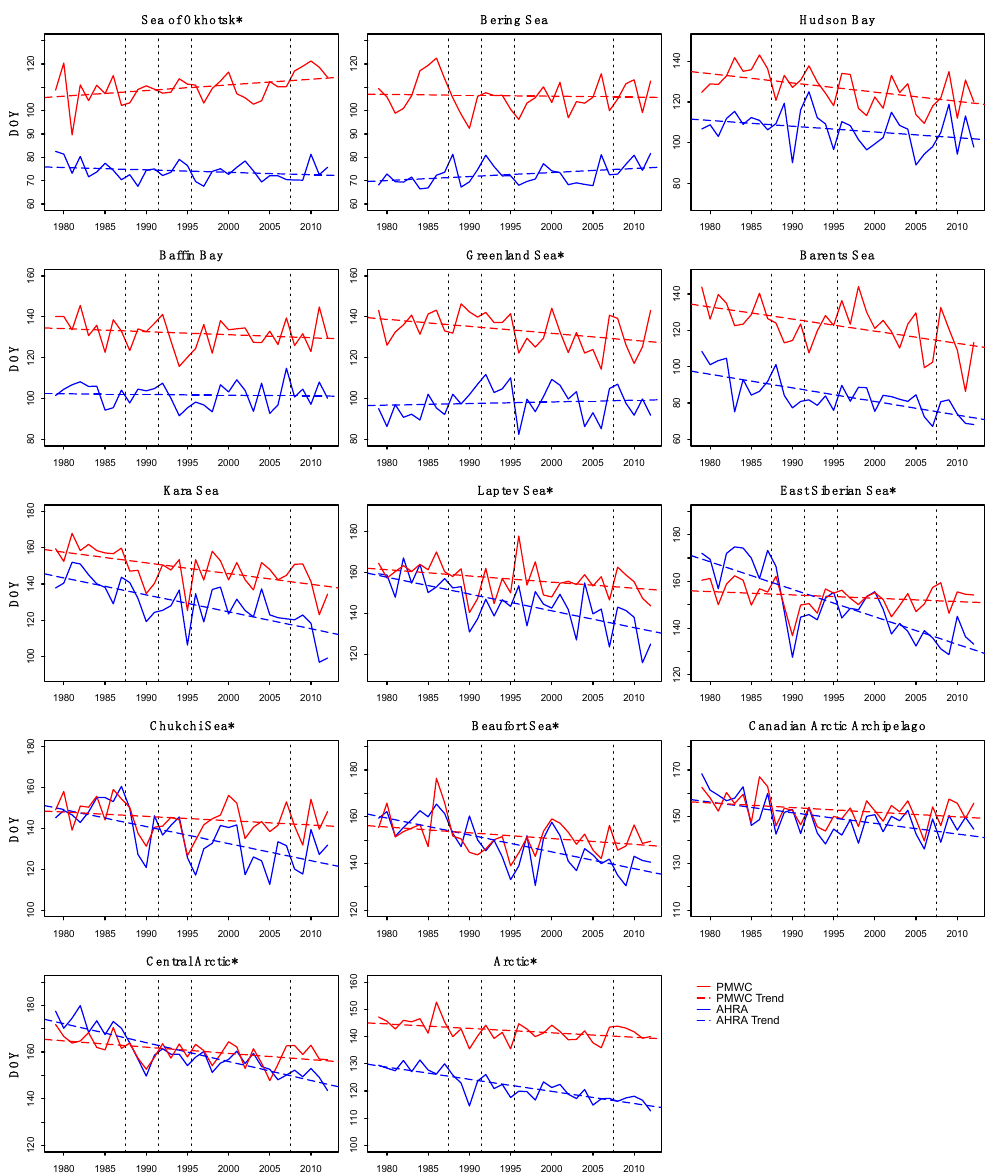
Figure 7. Annual mean MO date (DOY) for the AHRA and PMWC methods for 1979–2012. Least squares linear regression trends are shown as dashed lines. Vertical dotted lines indicate when changes in passive microwave satellite sensors occur. Trends are significantly different at the 95% confidence level based on a Student’s t -test in regions indicated with an asterisk.